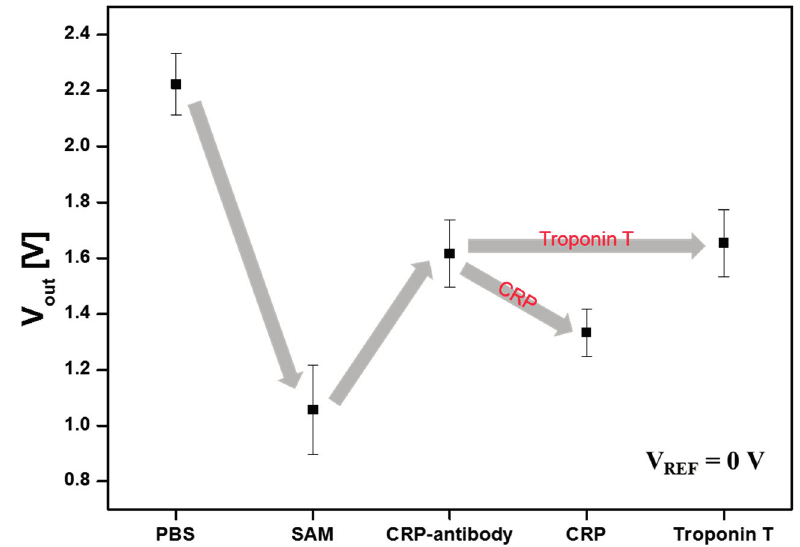
Figure 7. Output voltage characteristics of the AlGaN/GaN HEMT-based biosensor with